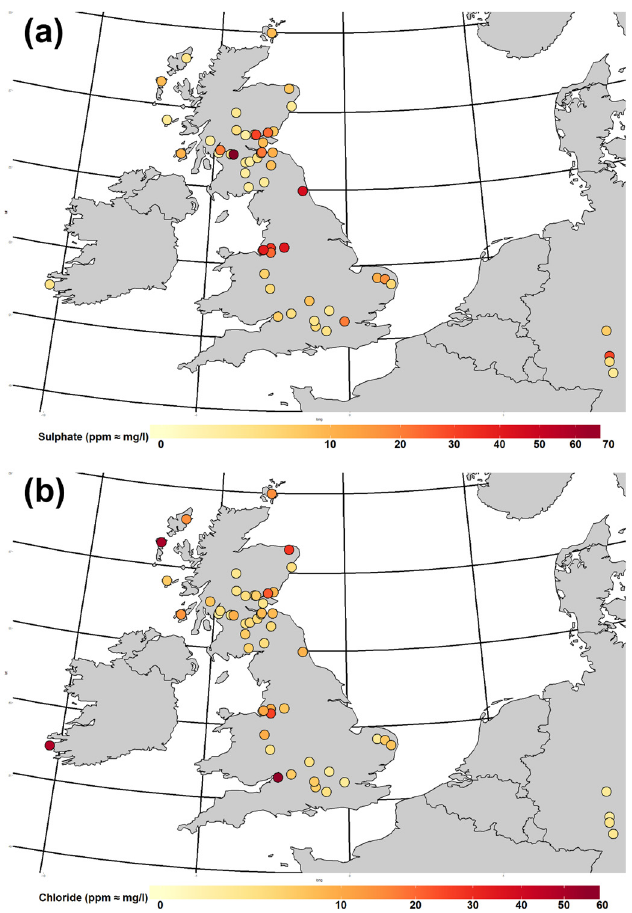
Figure 1. Spatial distribution of the monitoring network established by Robert Angus Smith, and the concentration of ( a ) sulphate and ( b ) chloride measured in single samples of precipitation collected at each site between 1869 and 1870.